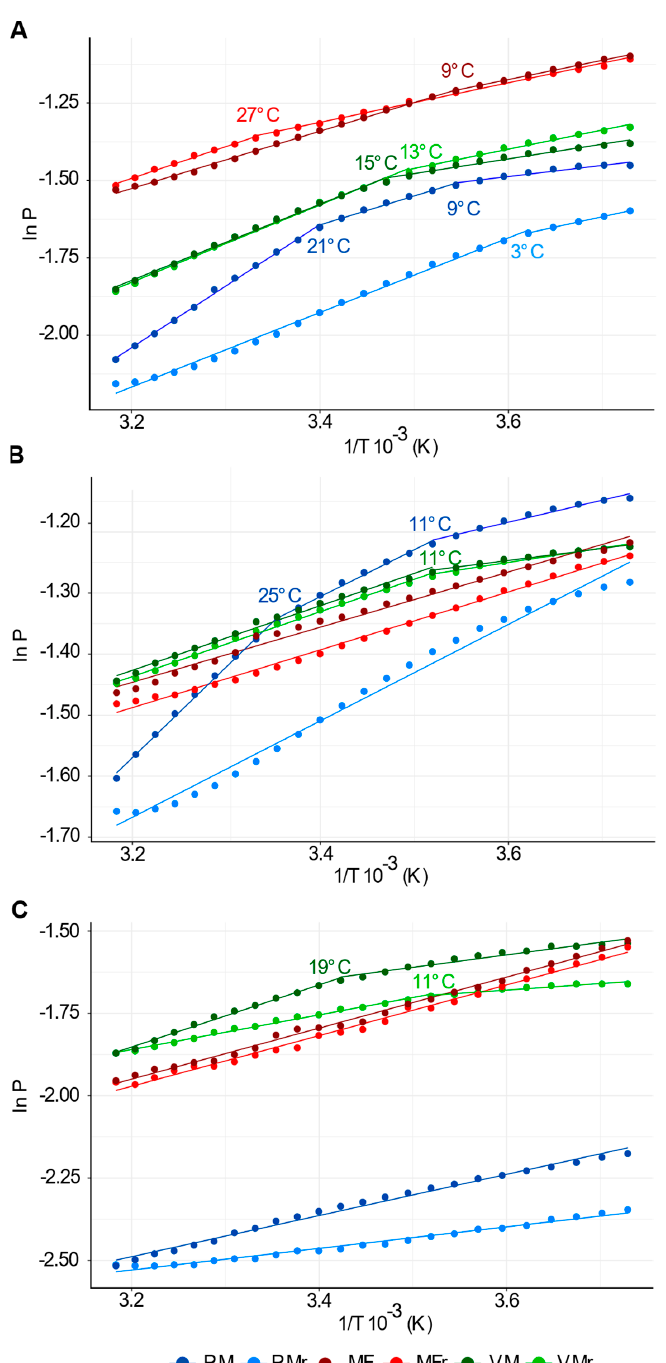
Figure 4. Arrhenius plots of the FP values from Figure 3. Data are shown as natural logarithm (ln) of P (polarization of fluorescence) versus the inverse temperature in Kelvin degrees (1/T 10 − 3 ) using ( A ) DPH, ( B ) TMA-DPH, or ( C ) PA as membrane fluidity probes. Curves were then analyzed by piecewise regression to find segments and breakpoints using “dpseg” package in R. Different segments and the temperature at which the breaking points occur are shown. Colors of dots and numbers at the breaking points of the lines correspond to the type of membrane and the direction of temperature change as indicated in the bottom labels. MF, VM, PM are determinations from mem- brane preparations subjected to a gradual increase of temperature. MFr, VMr, PMr are determinations from membrane preparations subjected to a gradual decrease of